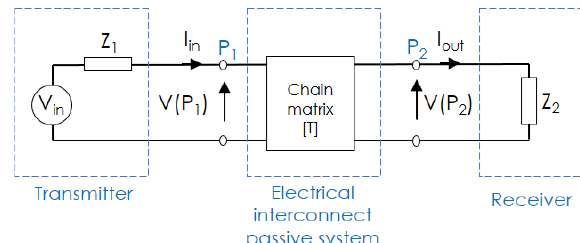
Figure 4: Electrical circuit equivalent to the diagram introduced in Fig. 3.